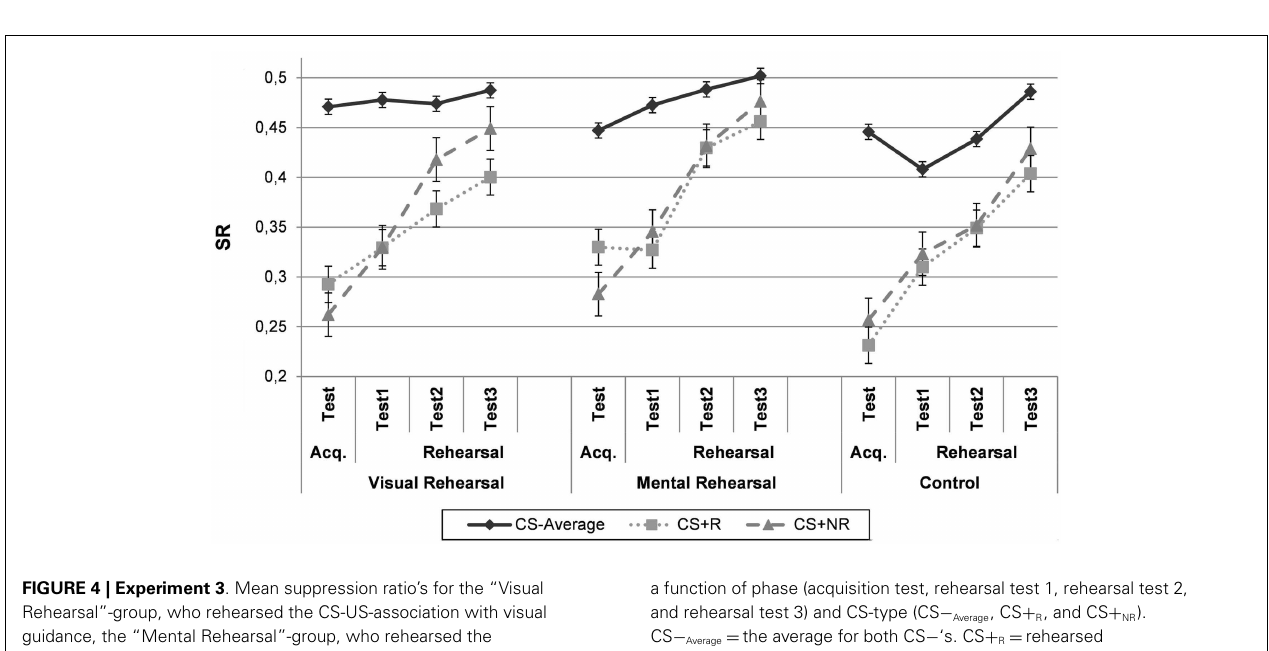
FIGURE 4 | Experiment 3 . Mean suppression ratio’s for the “Visual Rehearsal”-group, who rehearsed the CS-US-association with visual guidance, the “Mental Rehearsal”-group, who rehearsed the CS-US-contingency without visual guidance, and the “Control”-condition, who rehearsed an irrelevant picture-word pair, as